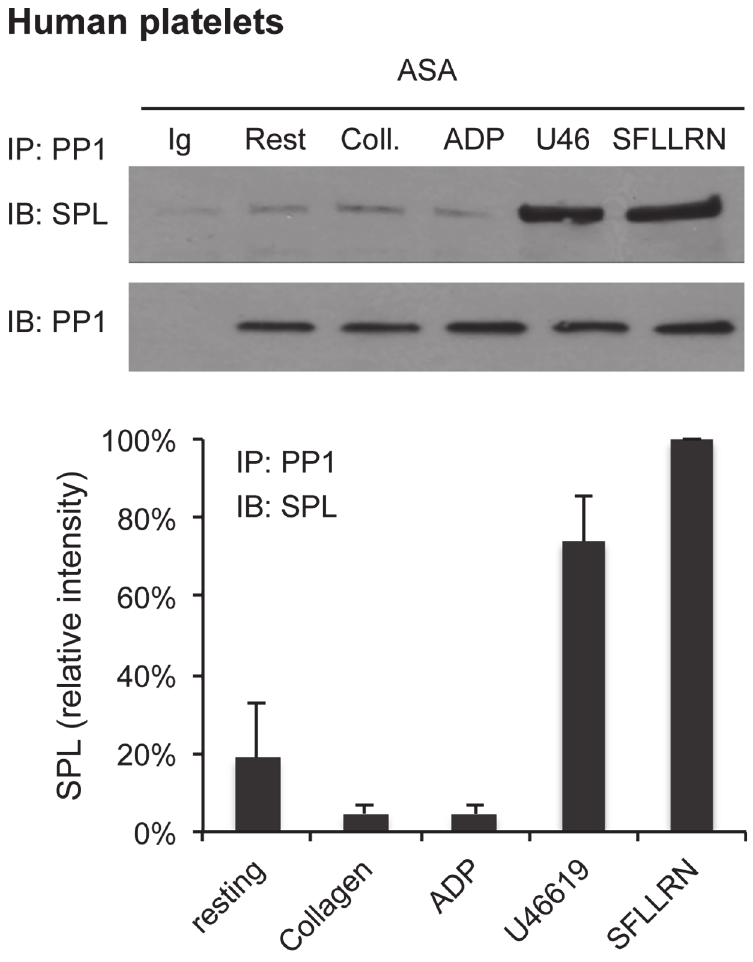
Fig 5. PP1 binding to spinophilin in platelets is agonist-selective. Human platelets were incubated for 3 min with 50 μ M SFLLRN, a TxA 2 mimetic (U46619 10 μ M), ADP (10 μ M) or collagen (10 μ g/ml) in the presence of 100 μΜ aspirin (ASA), after which the samples were lysed and placed on ice. Lysates were precipitated with anti-pan-PP1 (antibody E-9) and probed for spinophilin (antibody A-20) before being re-probed for PP1 (antibody FL-18). The results shown are the mean ± SEM, N =